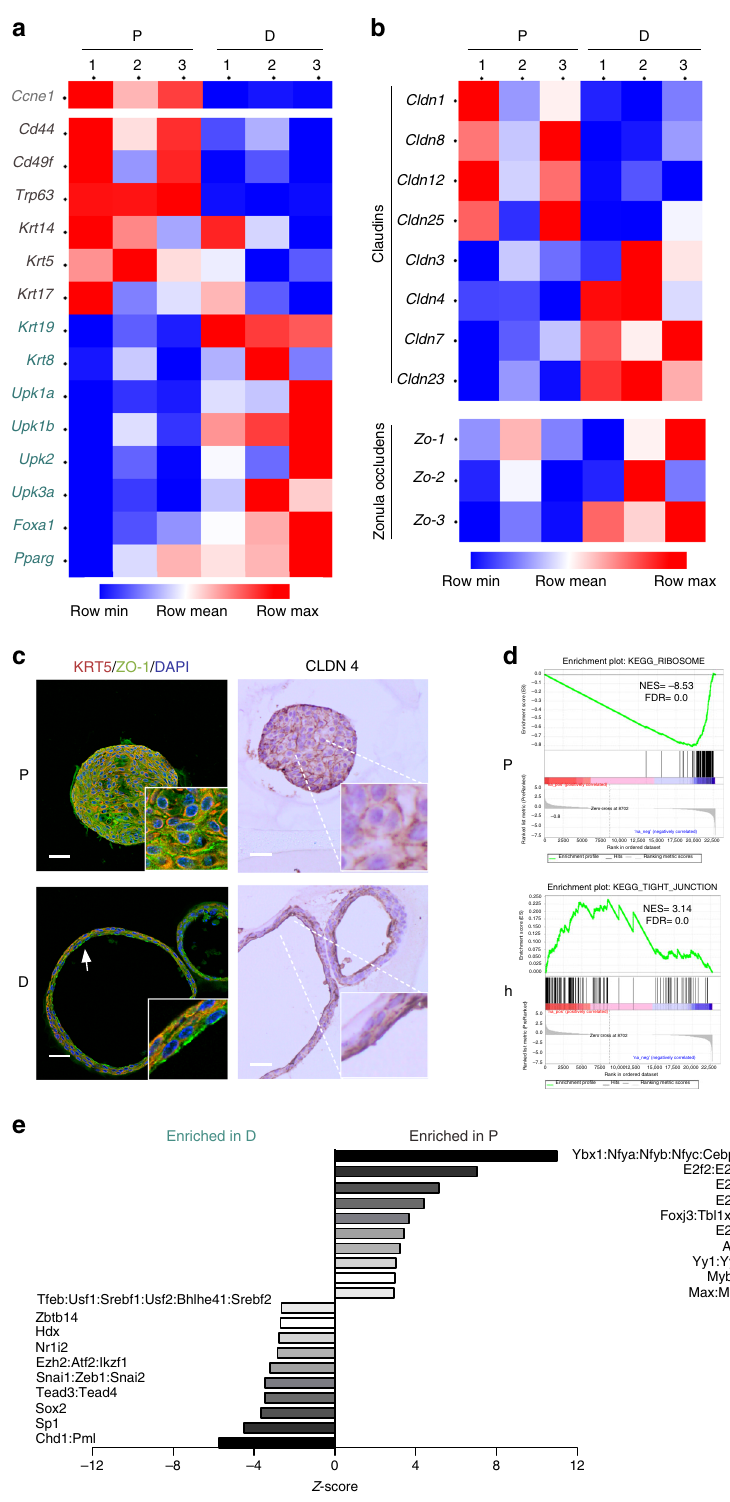
Fig. 6 Transcriptome analysis reveals organoid differentiation and identi fi es pathways involved therein. a Heatmap showing the expression (FPKM, RNAseq) of key urothelial differentiation genes in P and D organoids ( n = 3/group; paired samples). b Heatmap showing the expression of genes related to tight junctions (claudins and tight junction/Zo proteins) (FPKM) in P and D organoids ( n = 3/group). c Immuno fl uorescence analysis of the expression of ZO-1 and KRT5; immunohistochemical analysis of CLDN4 in the same samples; L (Lumen) (scale bar, 250 μ m). d Enrichment plots showing the upregulation of ribosome pathway genes and the downregulation of tight junction component genes in P organoids. e ISMARA analysis of top transcription factor motifs (ranked by z -scores) signi fi cantly enriched in the promoters of genes differentially expressed in P vs. D organoids; for the z -score of motifs enriched in D organoids. Source data are provided as a Source Data fi